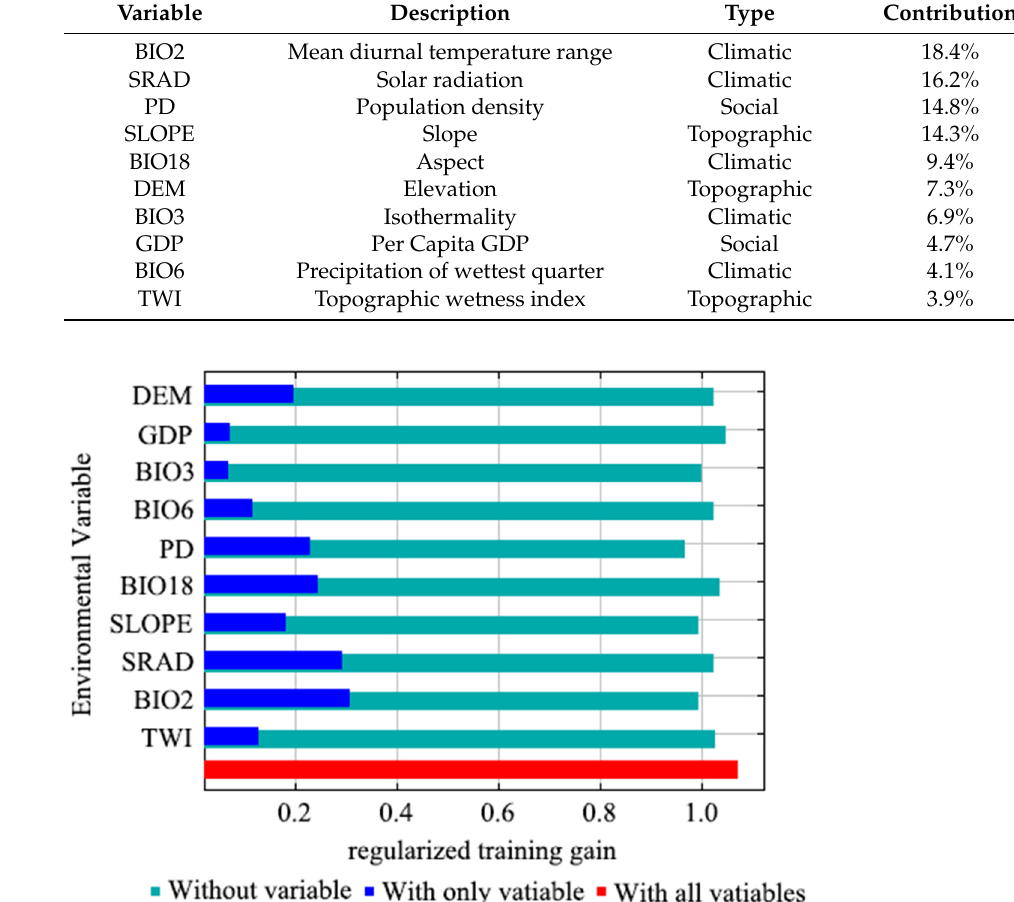
Figure 4. Jackknife test of the importance of environmental variables in MaxEnt model. The envi- ronmental variables in figure are mean diurnal temperature range (BIO2), slope (SLOPE), elevation (DEM), solar radiation (SRAD), isothermality (BIO3), population density (PD), min temperature of coldest month (BIO6), topographic wetness index (TWI), precipitation of warmest quarter (BIO18) and Per Capita GDP (GDP).